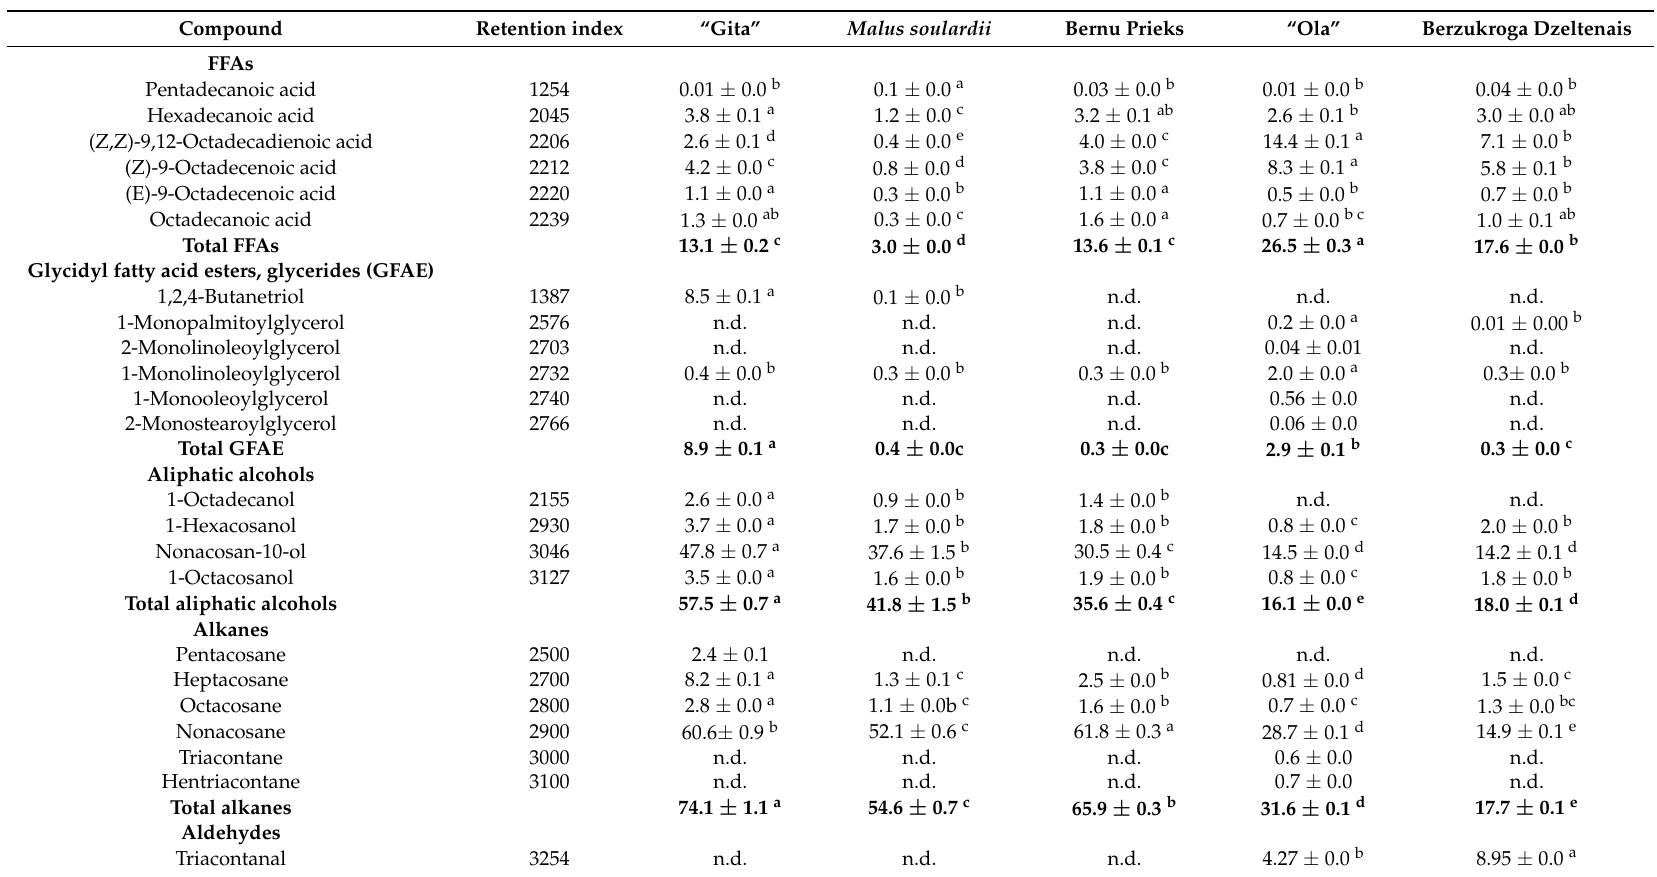
Table 2. Content of free fatty acids, glycidyl fatty acids, aliphatic alcohols, aldehydes, and alkanes in pomace oils recovered from Malus spp. crab apples, mg mL − 1